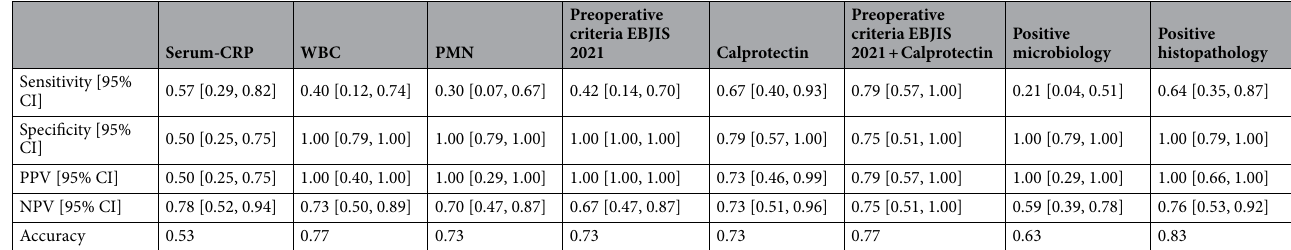
Table 2. Performance of preoperative criteria WBC, PMN, CRP, clinical features, calprotectin lateral flow assay, microbiological cultures and histopathological results. The EBJIS 2021 definition served as the gold standard; CRP, serum C-reactive Protein, WBC, synovial white blood cell count; PMN, percentage of polymorphonuclear neutrophils in synovial white blood cell count; CI, confidence intervall; PPV, positive predictive value; NPV, negative predictive value; EBJIS 2021, European Bone and Joint Infection society definition of periprosthetic joint infection published